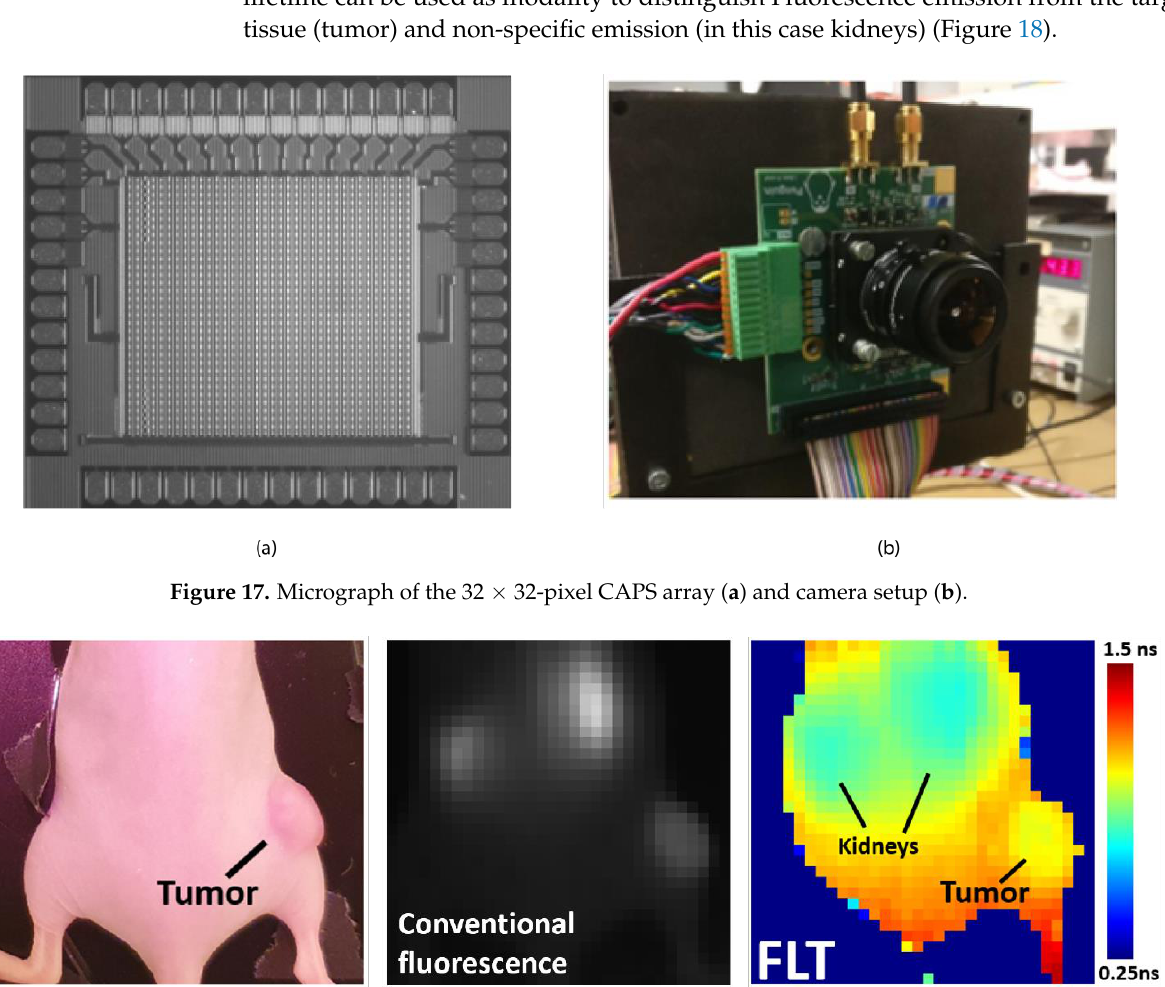
Figure 18. In vivo fluorescence experiment using a CAPS fluorescence-lifetime camera. A mouse bearing a xenograft tumor